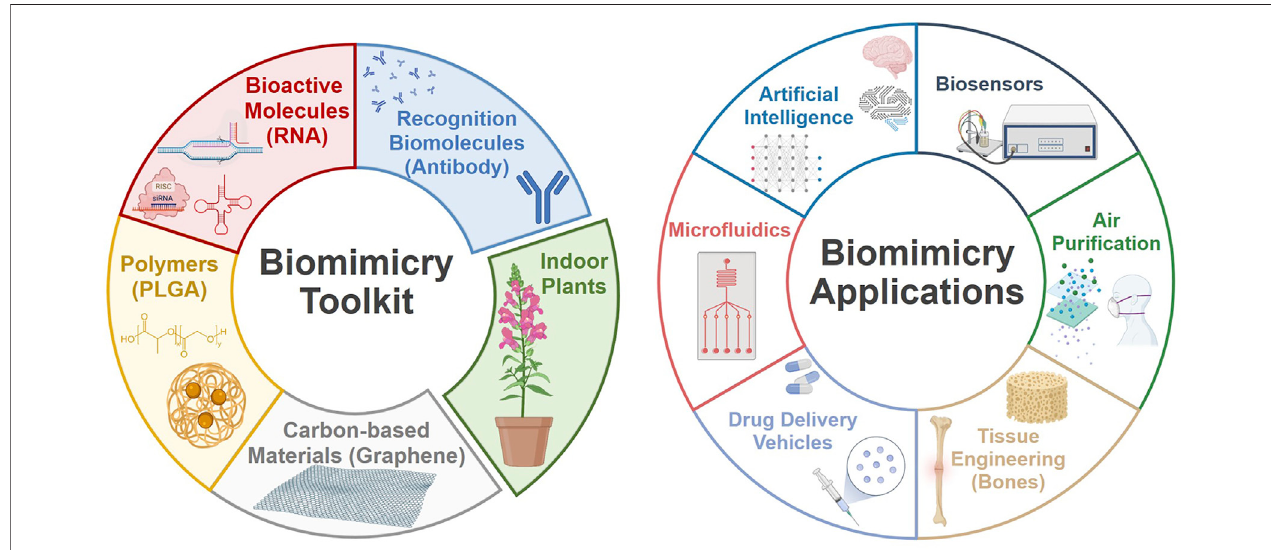
FIGURE 1 | Biomimicry: tools and applications (Created with